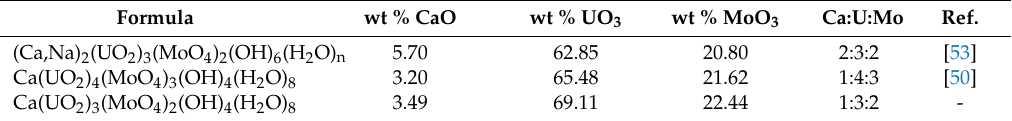
Table 12. Comparison of the chemical data reported for calcurmolite.